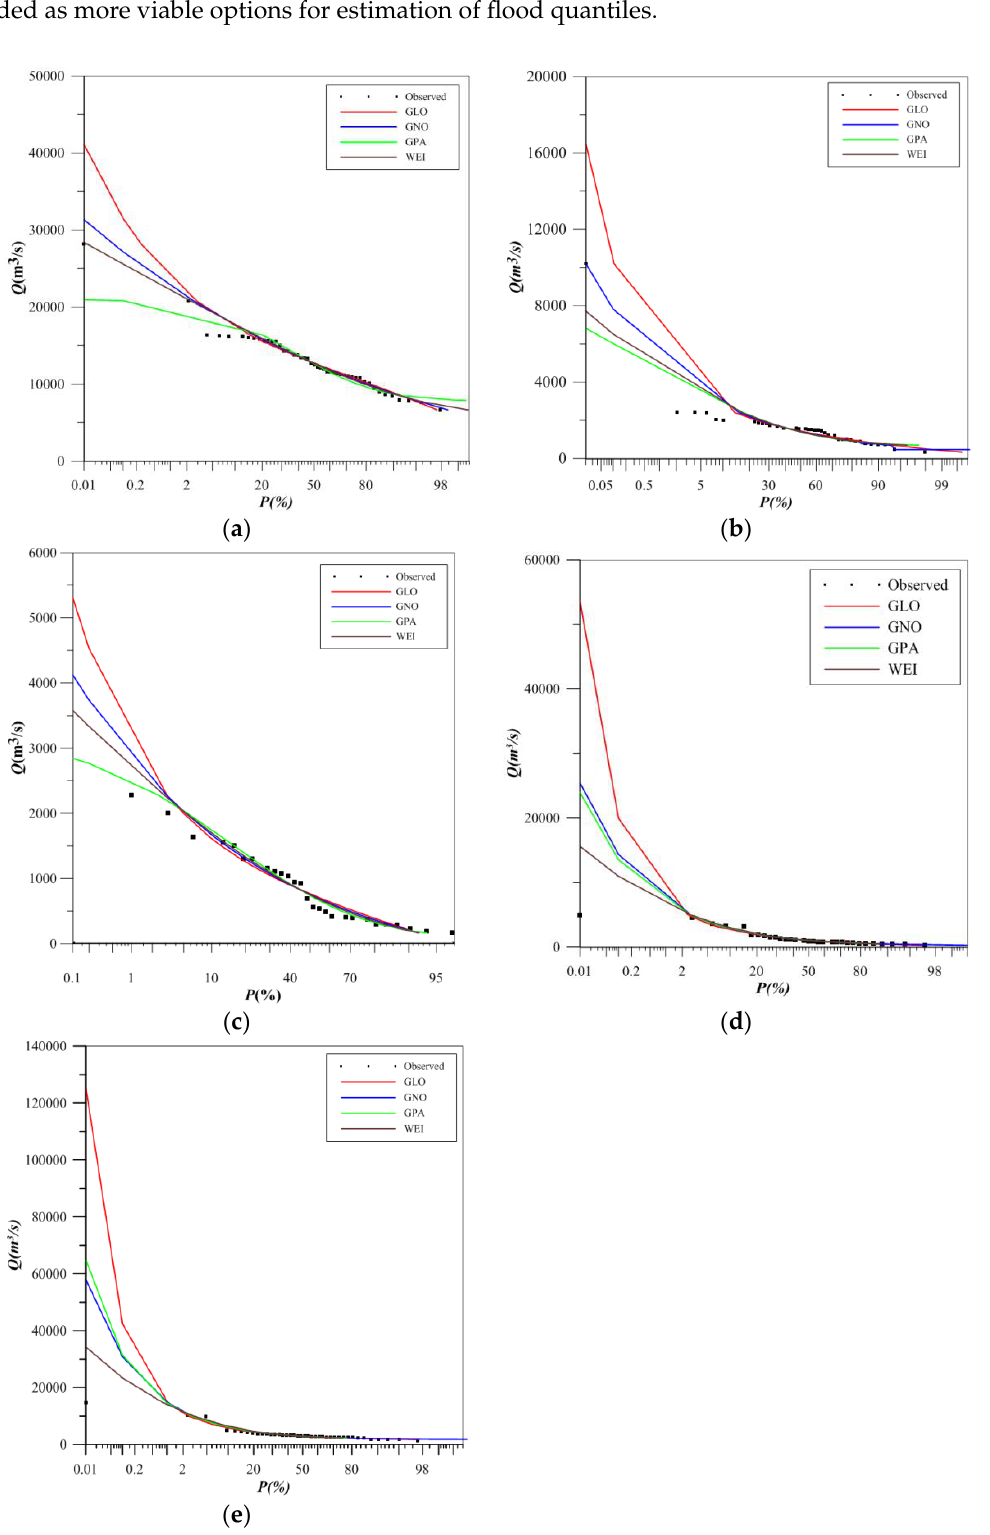
Figure 8. Flood frequency curves of GLO, GNO, GPA and WEI for ( a ) Attock, ( b ) Khiali, ( c ) Adezai, ( d ) Karot and ( e ) Khwazakhela.